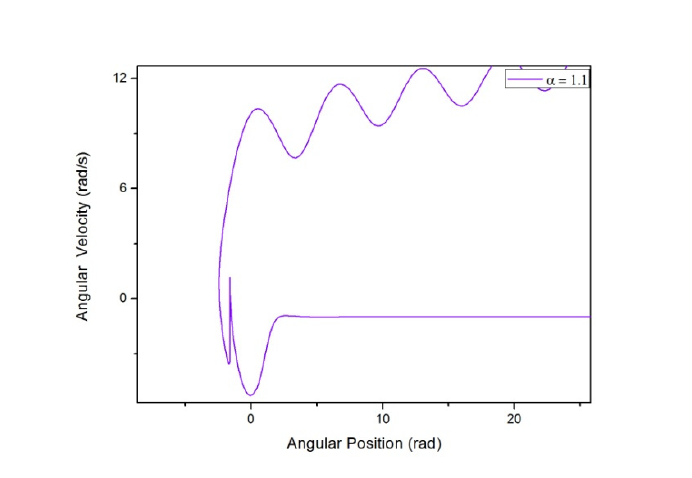
Figure 8. Pseudo-phase portrait (Case B for α = 1.0).